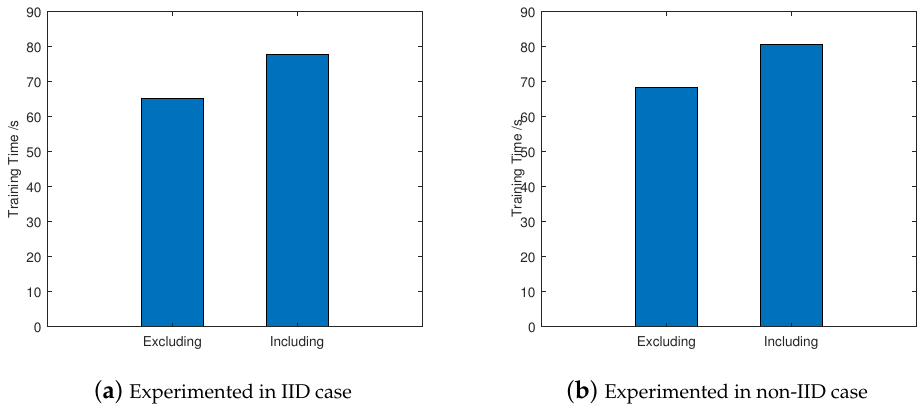
Figure 14. Comparisons of training time including and excluding blockchain of FL for CIFAR10 data set in IID and non-IID